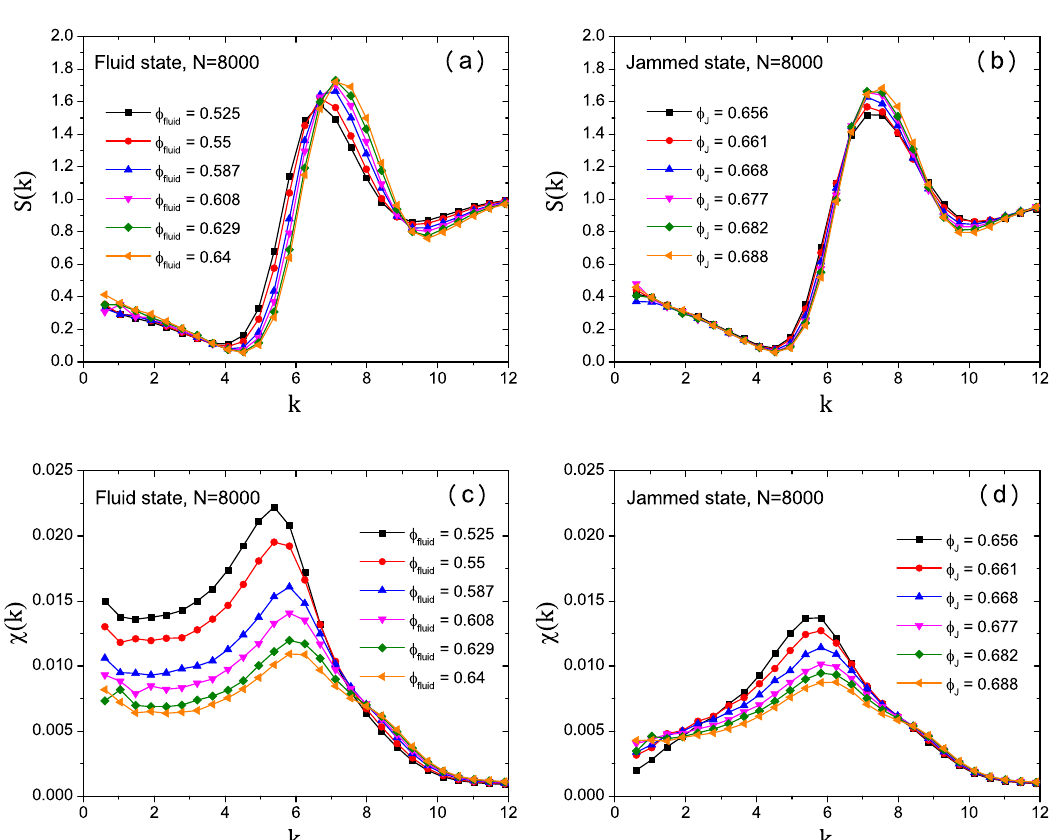
Figure 8: (a, b): Static structure factor S ( k ) reflecting number density fluctuations for fluid (a) k and jammed (b) states. (c, d): Spectral density χ ( k ) reflecting volume fraction fluctuations for fluid (c) and jammed (d) states. Nearly hyperuniform behavior expected for χ ( k ) is only observed for the lowest φ value in J